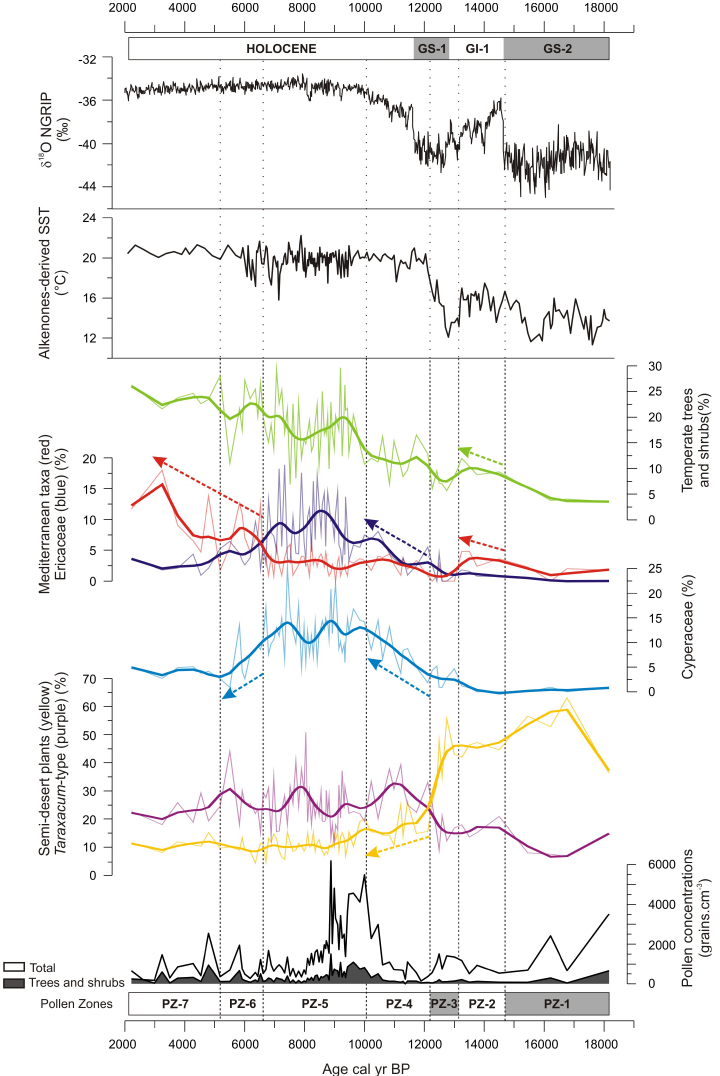
Fig. 4. Vegetation and climatic changes over the last 18000yr. From the bottom to the top: tree (excluding Pinus ) and shrub (grey) and total (white) pollen concentrations, pollen percentages of selected pollen taxa and ecological groups, SST derived from alkenones (Sicre et al., 2013) from core MD04-2797CQ, δ 18 O from NGRIP ice core on GICC05 time-scale (converted to BP) (Rasmussen et al., 2006; Vinther et al., 2006). Long-term Holocene vegetation evolution has been detected by applying a smoothing cubic spline method to selected pollen taxa data. Pollen zones (bottom) and stratigraphical framework (top) are indicated. Note that we will name the Younger Dryas as Greenland Stadial 1 (GS-1), following the INITIMATE recommendations (Lowe et al., 2008), but we will keep using Heinrich Stadial (HS1) in the text (as defined by S´anchez Go˜ni and Harrison, 2010) because the isotopic changes during GS-2 are difficult to reconcile from one Greenland ice core to another (Rasmussen et al., 2008) and the correlation between GS-2a and HS1 has to be